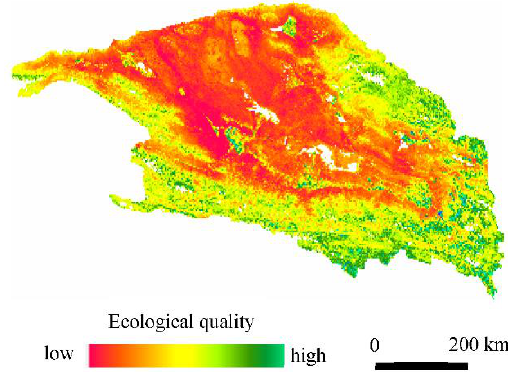
Figure 4. MRSEI image of the Qaidam